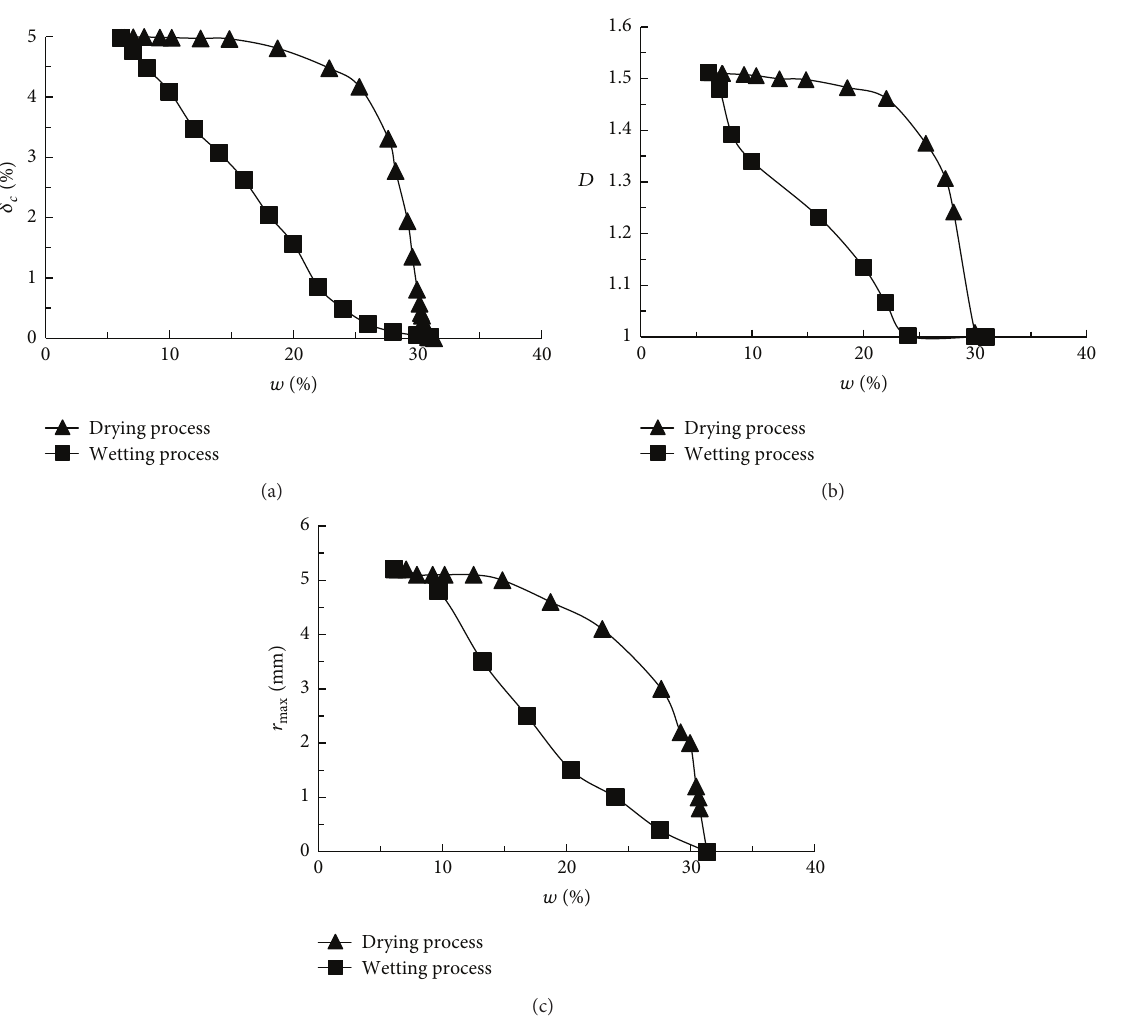
Figure 6: Changes of crack morphological parameters with water content. (a) Crack porosity 𝛿 𝑐 . (b) Crack fractal dimension 𝐷 . (c) The maximum crack width 𝑟 max